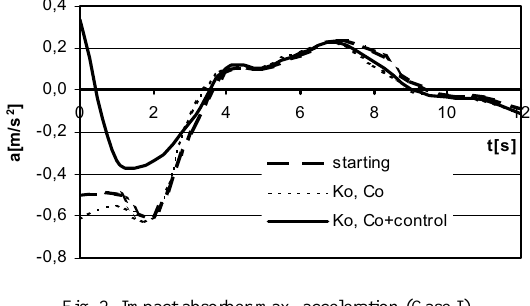
Fig. 2. Impact absorber max. acceleration (Case I).